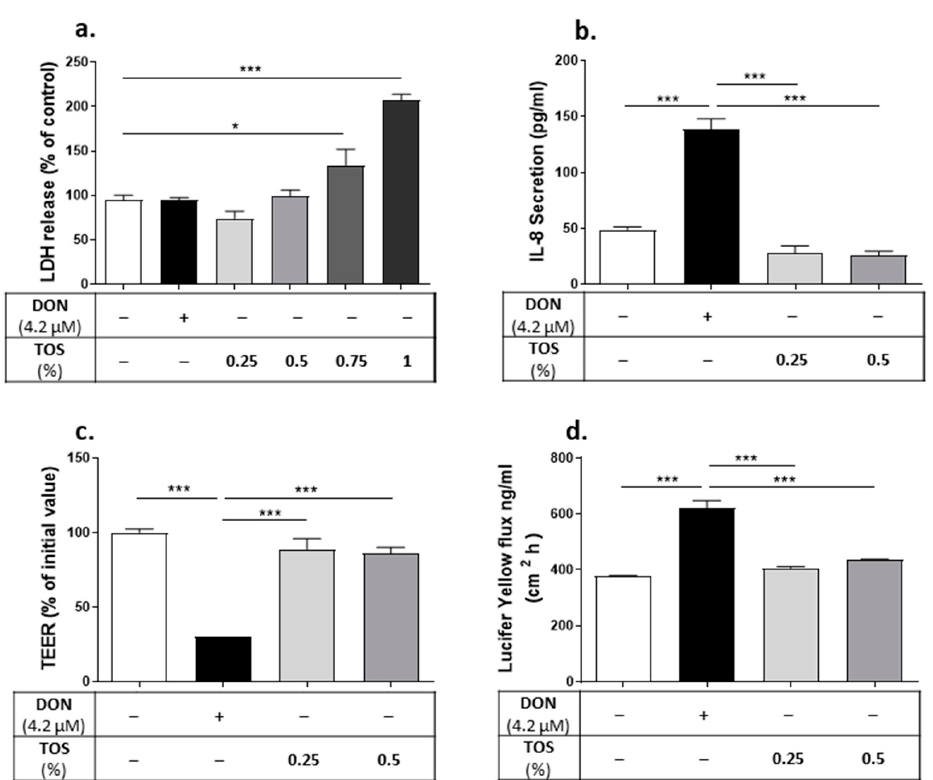
Figure 10. Protective effect of trans-galacto-oligosaccharides (TOS) on deoxynivalenol (DON)-induced adverse effects on Caco-2 cell monolayer. Lactate dehydrogenase (LDH) release in cell supernatant ( a ); IL-8/CXCL8 concentration in cell supernatant ( b ); trans-epithelial electrical resistance (TEER) ( c ) and lucifer yellow flux ( d ). Data are presented as mean ± SEM of 3 independent experiments performed in triplicate. * p < 0.05 and *** p < 0.001 indicate statistical differences.